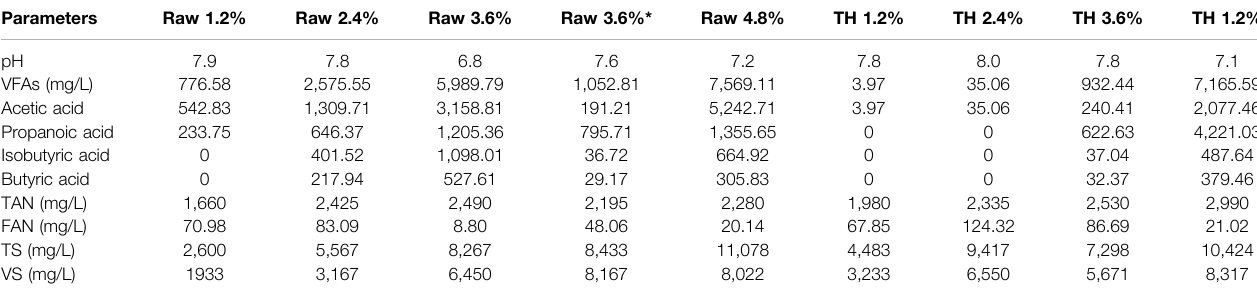
TABLE 3 | Process stability indicators after batch AD tests.